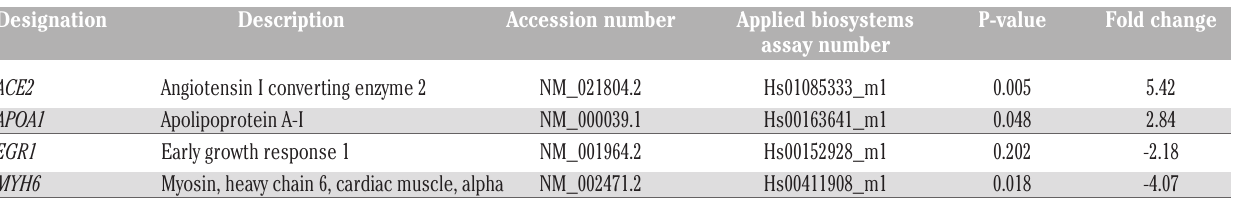
Table 6. Gene characteristics and results of real time polymerase chain reaction analysis in patients vs.